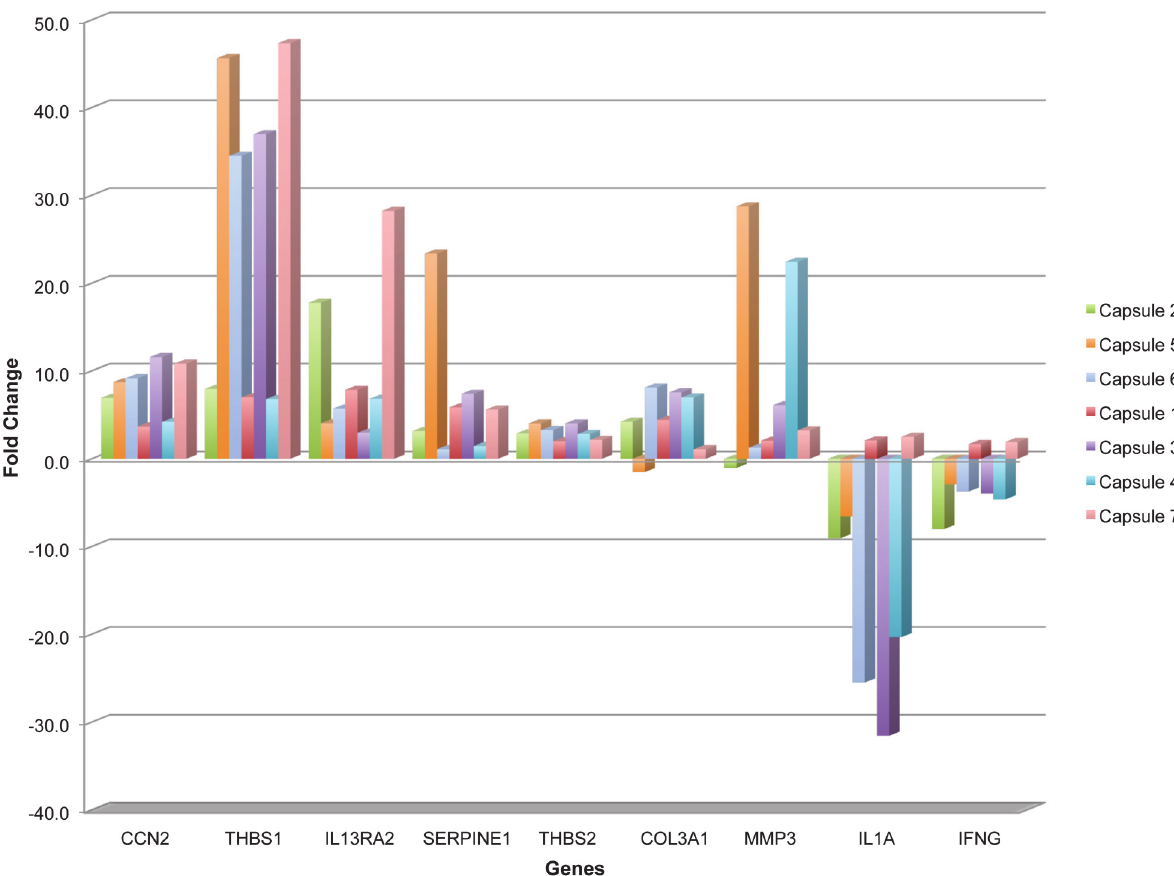
Fig 2. Differential expression of genes identified by Human Fibrosis PCR-Array analysis in failed AGV capsules. Capsules 2, 5 and 6 were from patients below 18 years and capsules 1, 3, 4 and 7 were from patients above 18 years of age. Validated gene changes were deregulated in majority of the